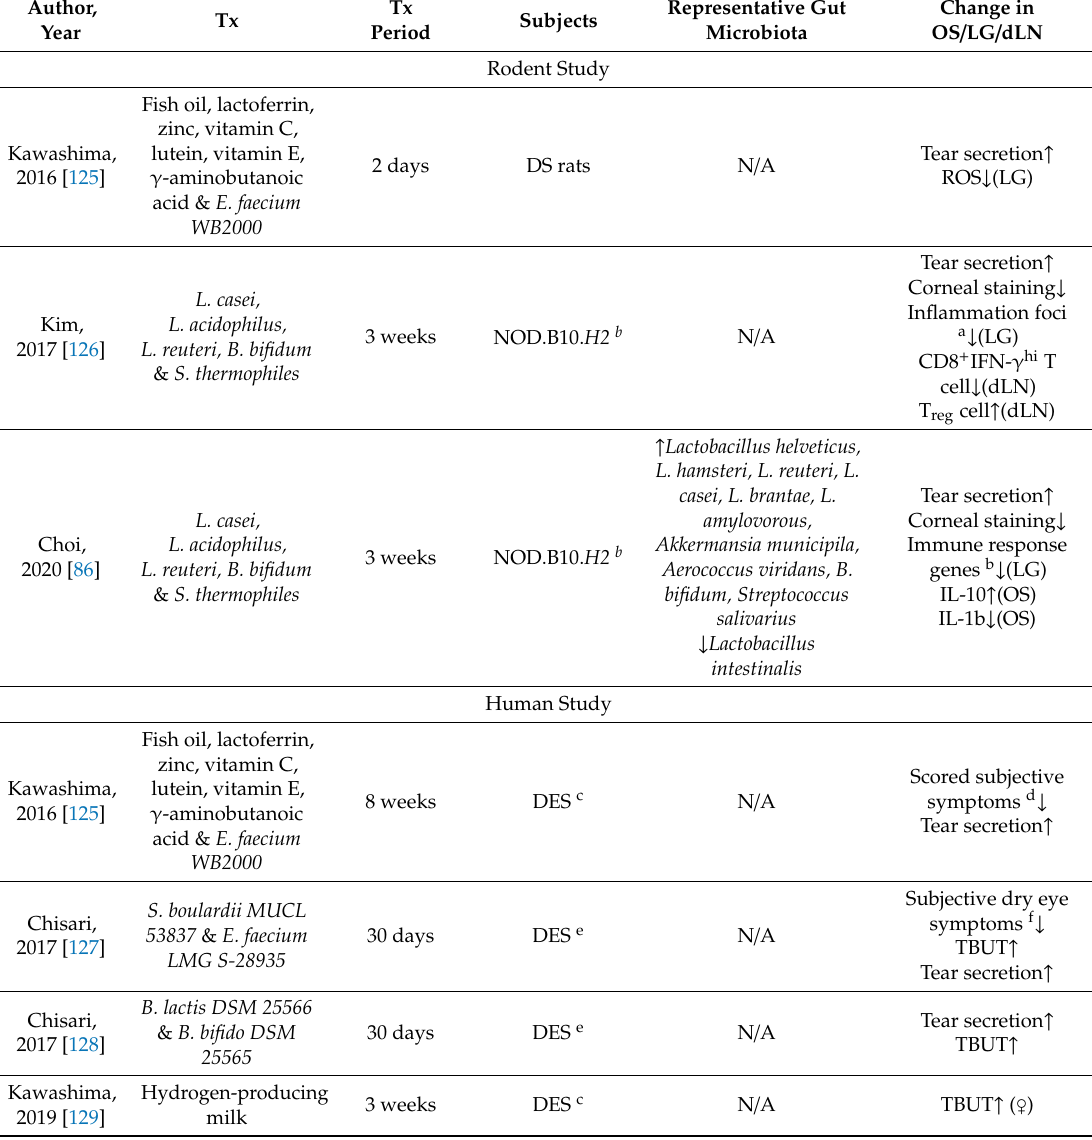
Table 6. E ff ects of probiotics or prebiotics on dry eye in rodent and human